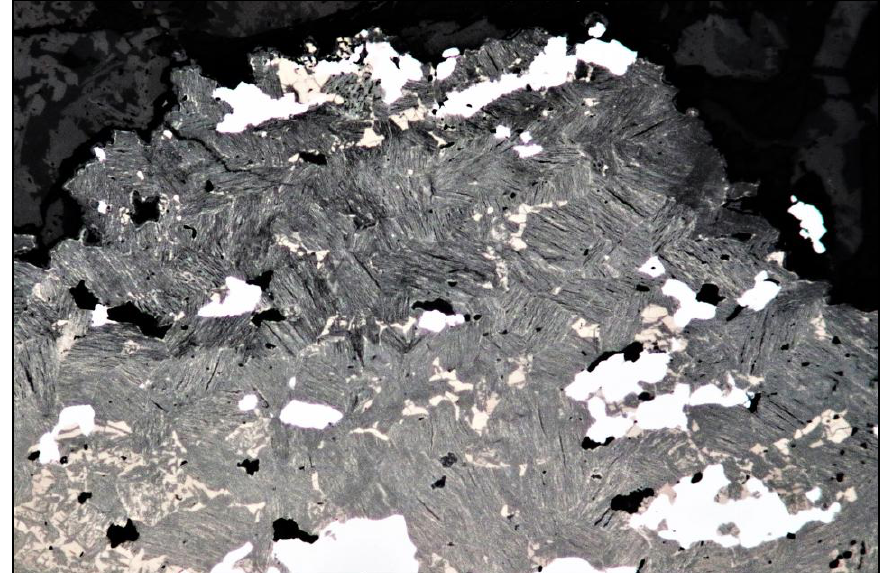
Figure 16. Eskebornite (light-brown) and clausthalite (bright) largely replaced by unknown Cu–Fe selenites (light-grey to dark-grey) of strongly varying Cu/Fe ratios, from Cu > Fe to Cu = Fe to Cu < Fe, possibly representing chalcomenite and mandarinoite. The darker the domains are, the more Fe-rich is the alteration mineral. Reflected light image, 500-μm-wide, plane polarized light.